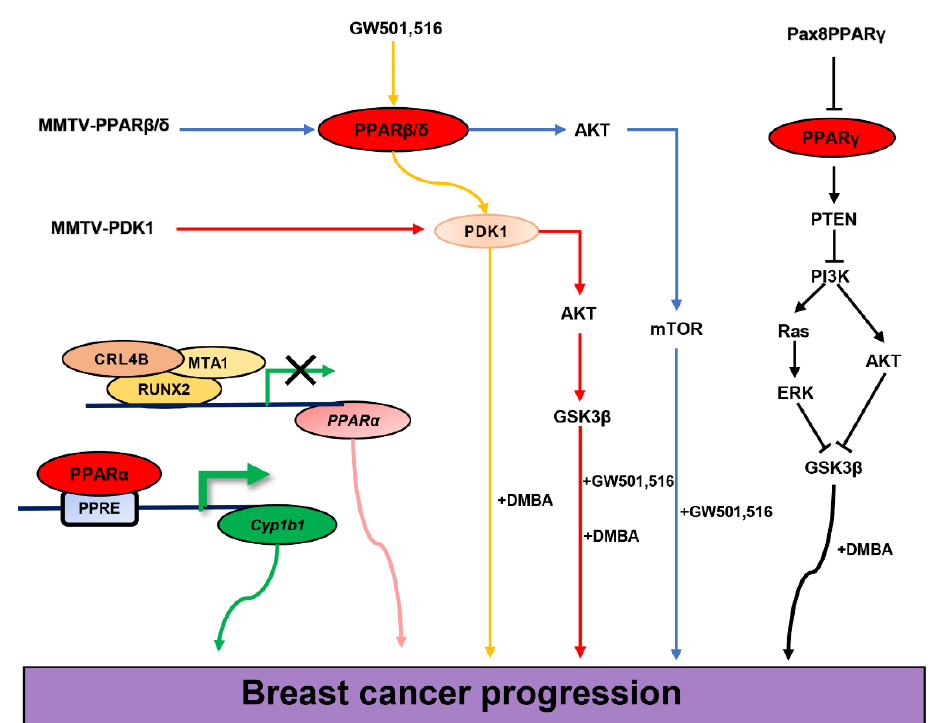
Figure 6. Schematic illustration of ligand-activated or ligand-independent PPARs affecting breast cancer progression. PPRE: peroxisome proliferator response element; Cyp1b1 : cytochrome P450 1B1; RUNX2: Runt-related transcription factor 2; MTA1: metastasis-associated 1; CRL4B: Cullin 4B-Ring E3 ligase; PDK1: 3-phosphoinositide-dependent protein kinase 1; PTEN: phosphatase and tensin homolog; AKT: AKT serine/threonine kinase 1; GSK3β: glycogen synthase kinase 3β; mTOR: mechanistic target of rapamycin kinase; PI3K: phosphatidylinositol-4,5-bisphosphate 3-kinase; ERK: mitogen-activated protein kinase 1; DMBA: 7,12